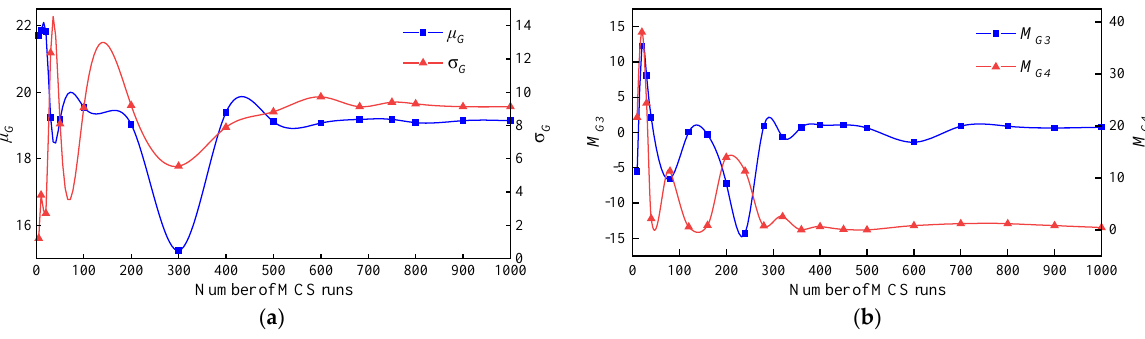
Figure 10. The convergence of the central moments of the performance function with the number of MCS runs: ( a ) mean and standard deviation; ( b ) third-order dimensionless central moment and fourth-order dimensionless central moment.